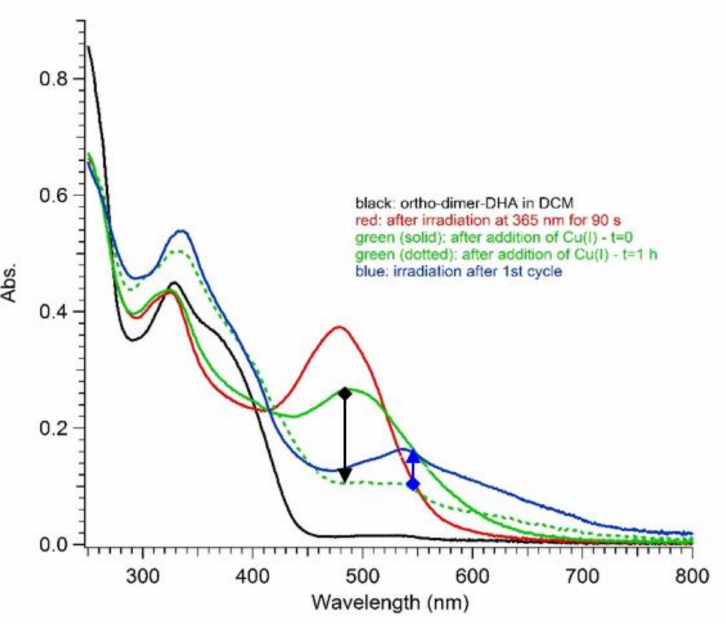
Figure 8. UV-Vis absorption spectra in DCM of ortho -DHA-dimer 4: before irradiation (black line); after irradiation at 365 nm for 5–90 s (red lines); after addition of Cu(CH 3 CN) 4 BF 4 at t = 0 (green solid line); one hour after addition of Cu(I) ions (green dotted line); and after irradiation at 365 nm to verify residues of activity (blue line). The black arrow highlights the thermal transformation and the blue arrow points out the photoactivity